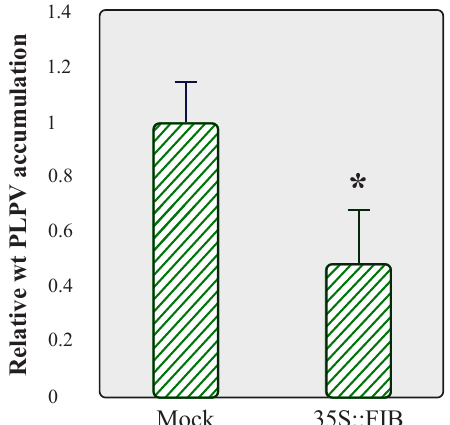
Figure 6. Analysis of PLPV accumulation in N. benthamiana leaves overexpressing fibrillarin. N. ben- thamiana leaves were agroinfiltrated with a pROK2-based plasmid directing expression of FIB:mRFP or with a plasmid without insert (mock control), and at 3 dpif, the leaves were agroinoculated with wt PLPV. Total RNA preparations were obtained at 3 dpi and subjected to RT-qPCR to estimate relative viral accumulation. The bars depict the standard deviation from three independent biological replicates. The statistical significance was evaluated using a paired t -test (* p < 0.05).